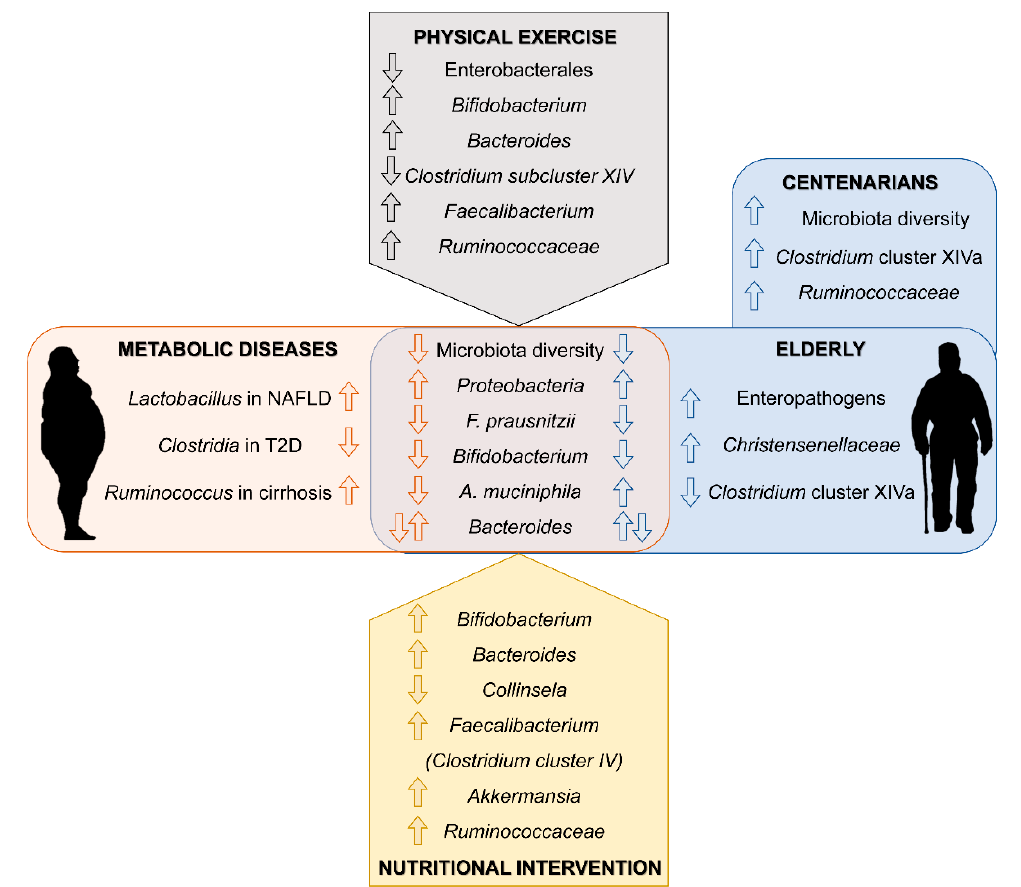
Figure 1. Main findings in gut microbiota composition linked to metabolic disease and aging (center). Summary of related changes observed in response to physical activity and nutritional interventions in elderly individuals (top and bottom respectively).